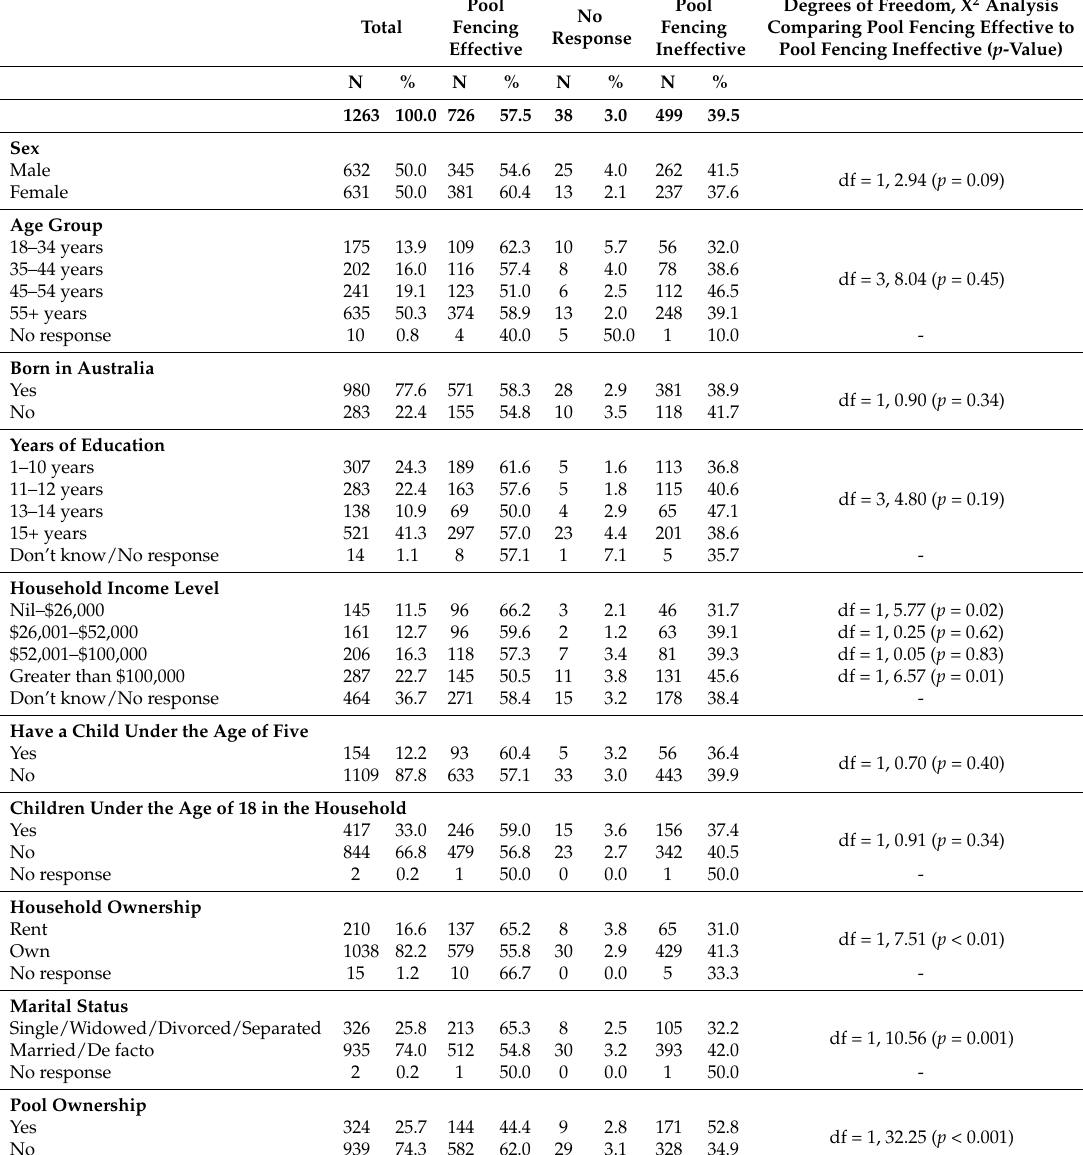
Table 2. CATI survey responses by pool fencing effective/ineffective by sex, age group, born in Australia, years of education, household income level, child under the age of five, child under the age of 18 in the household, household ownership, and marital status, Queensland, 2011 ( N = 1263). Pool Fencing